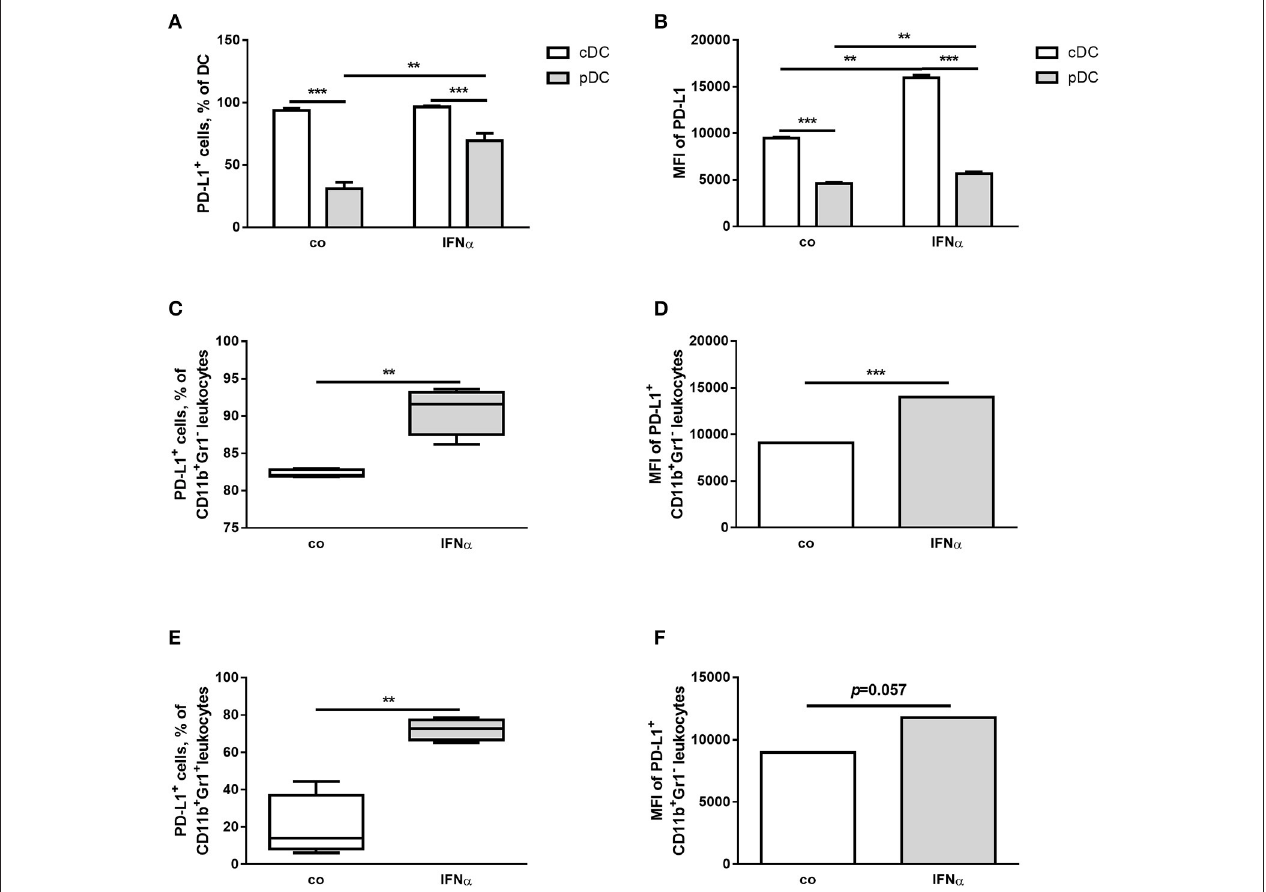
FIGURE 1 | IFN α up-regulates PD-L1 expression on different myeloid immune cell populations ex vivo. FACS analysis of PD-L1 expression on the surface of different myeloid immune cells from splenocytes of healthy mice. Splenocytes were isolated, treated for 24h with 1,000 U/ml IFN α and investigated by flow cytometry. The results are presented as interleaved bars (A,B) , as box and whiskers plots (C,E) or column bar graphs (D,F) and statistically analyzed using two-way ANOVA (A,B) or unpaired T -tests (C–F) , n = 4, ** p < 0.01, and *** p <